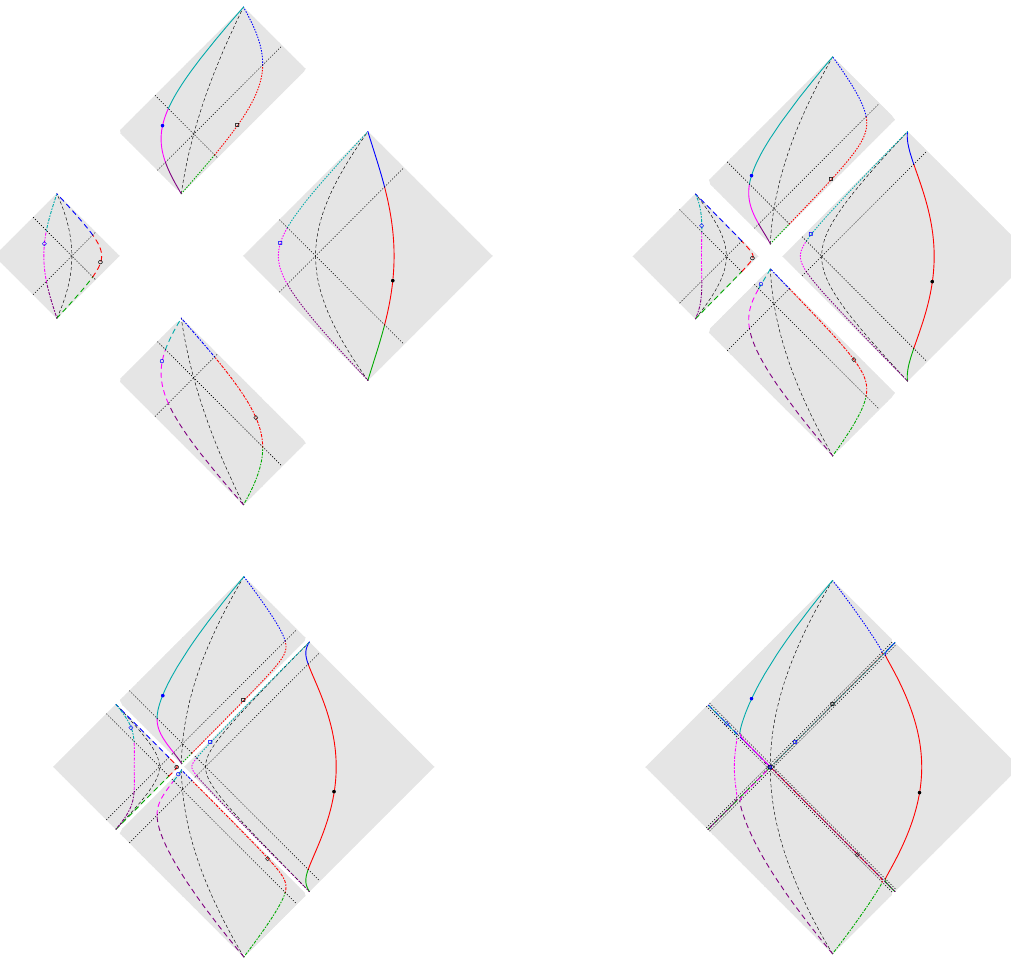
Figure 11 . Spacetime domain D A for the union of two disjoint intervals A 1 and A 2 on the line, whose lengths are ‘ 1 = ‘ and ‘ 2 = 2 ‘ respectively. The distance d between the intervals changes in the different panels, while ‘ is kept fixed: d/‘ = 1 (top left), d/‘ = 1 / 5 (top right), d/‘ = 1 / 20 (bottom left) and d/‘ = 1 / 1000 (bottom right). The modular trajectories corresponding to following two choices of the initial point P are displayed: the black filled circle in D 2 and the blue filled circle in D + . The empty symbols having the same colour denote the conjugate point P 12 and the auxiliary points P (empty square and empty rhombus) obtained from P c , ±